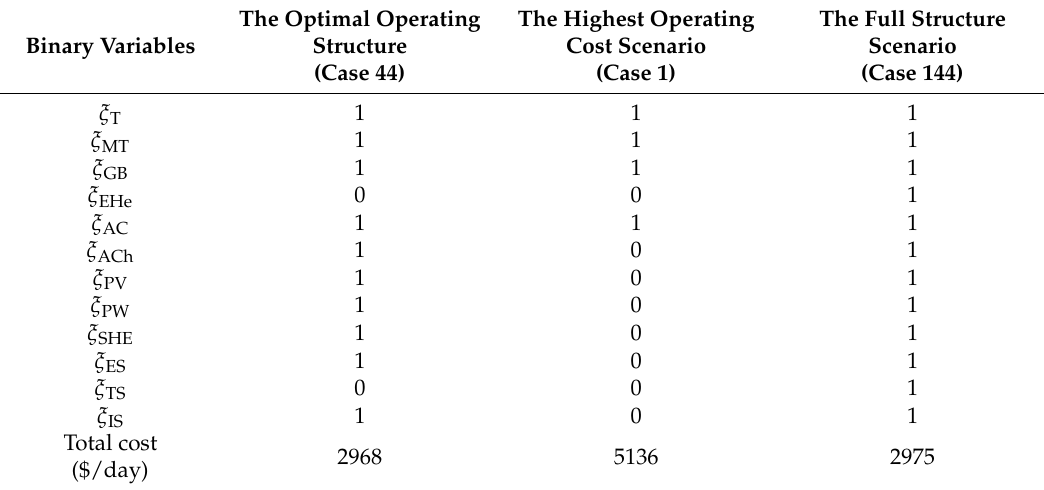
Table 3. The optimal operating structure corresponding to the value of binary